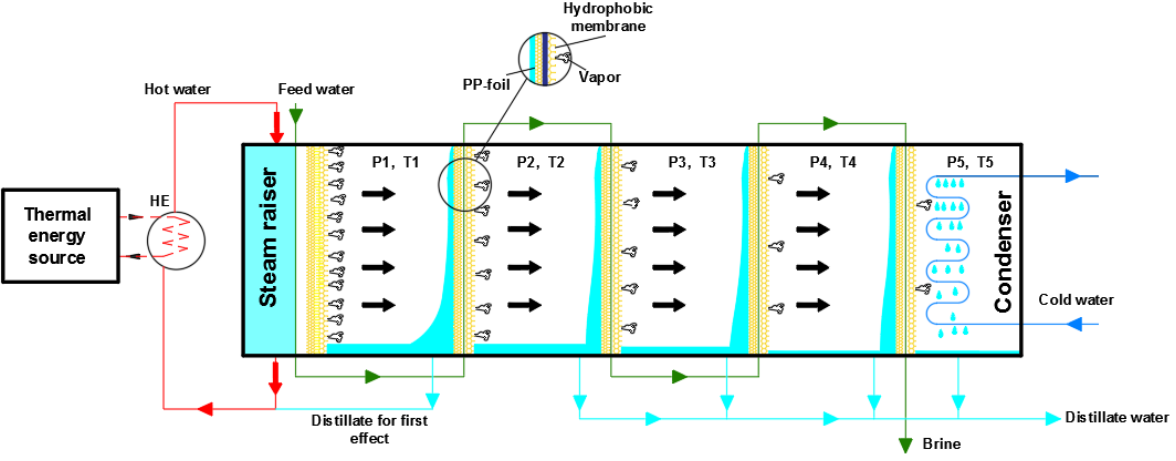
Figure 2. Schematic diagram showing the principle of V-MEMD.